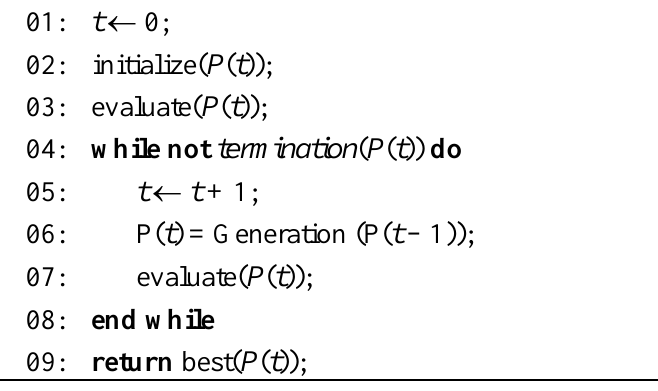
Algorithm 1: the genetic-based optimization algorithm.